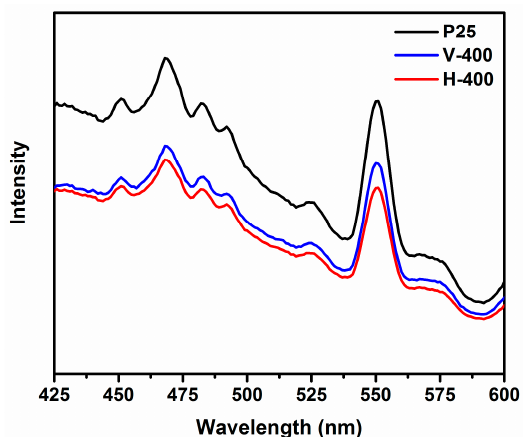
Figure 7. PL spectra of P25, V-400 and H-400 (excitation wavelength was 325 nm).